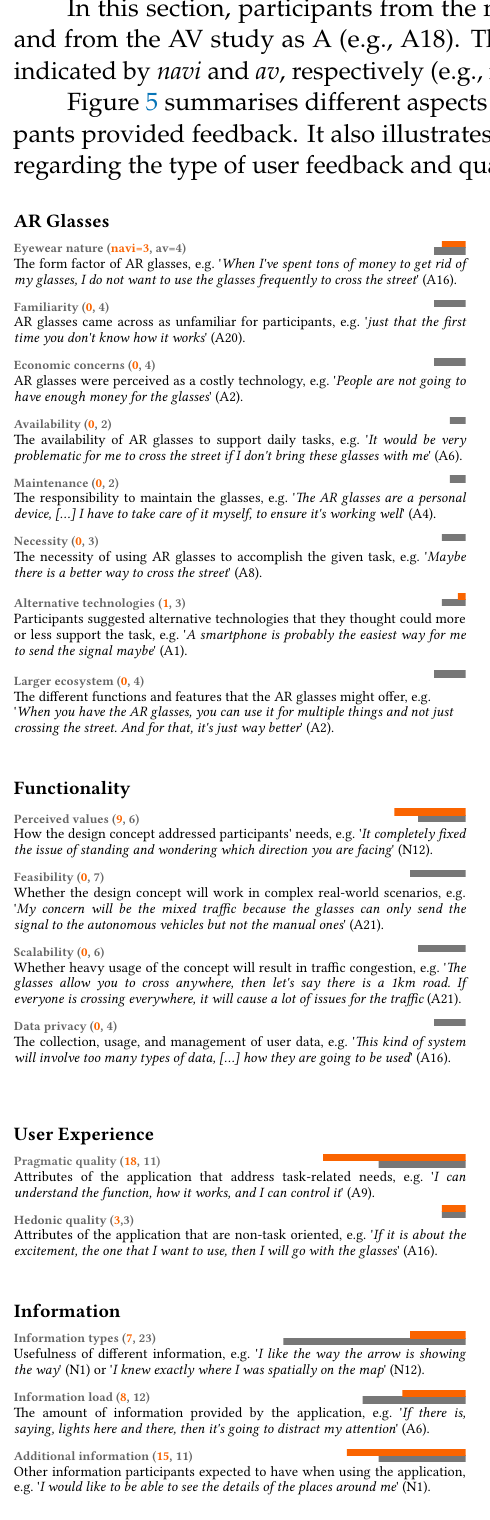
Figure 5. Different aspects of the AR prototypes about which the participants provided feedback. The orange bar represents the navigation study; the grey bar represents the AV study. The bar length represents the number of participants who provided feedback for a specific aspect for the navigation study and the AV study,